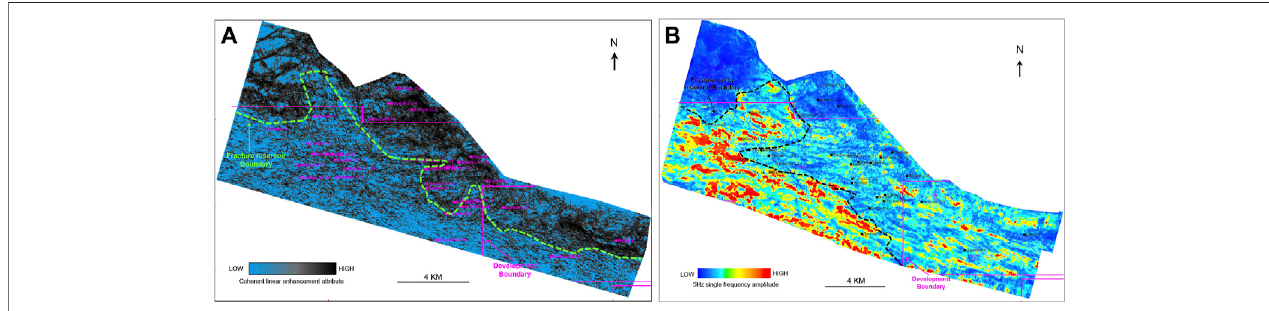
FIGURE 8 | (A) Prediction map of the fractured granitic buried-hill reservoirs in the BC block (100 m below buried-hill surface). (B) Prediction map of the fractured- cave granitic buried-hill reservoirs in the BC block (0 – 100 m below the buried-hill surface).